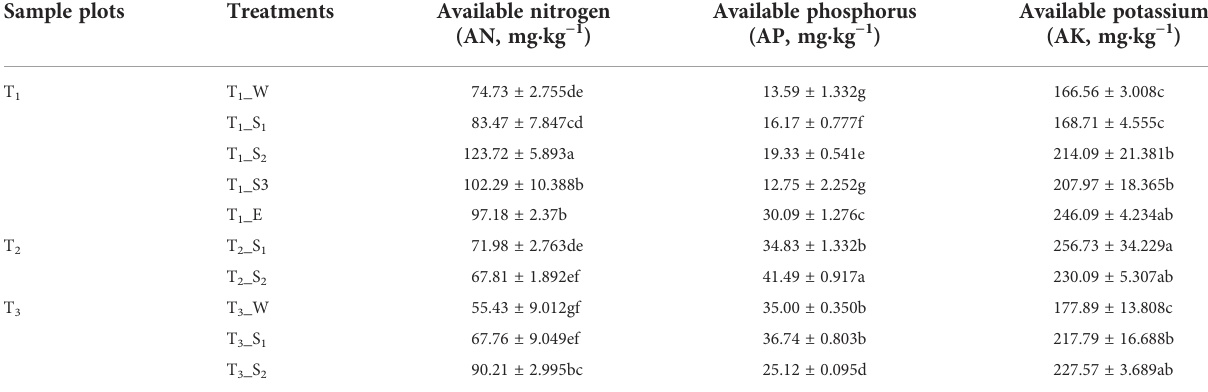
TABLE 2 Available nutrient content in the soil beneath the different tree species. Sample